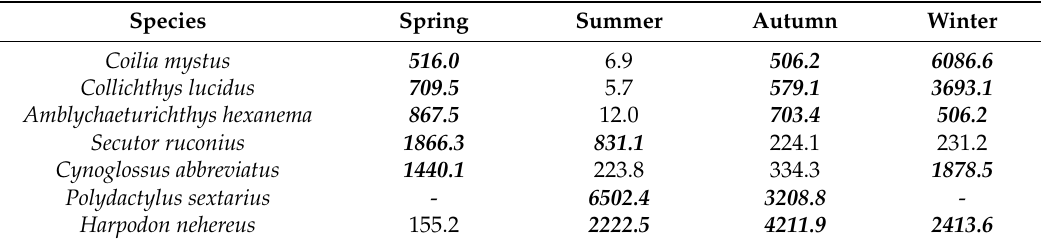
Table 1. The index of relative importance ( IRI ) for seven dominant fish species in the Min River Estuary in di ff erent seasons in